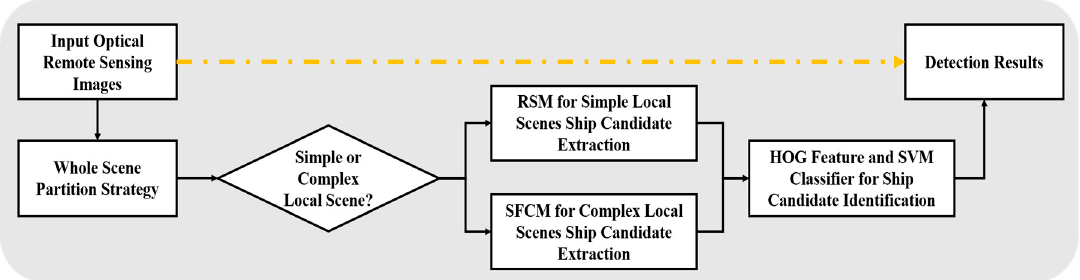
Figure 2. Workflow of the proposed ocean ship detection framework.